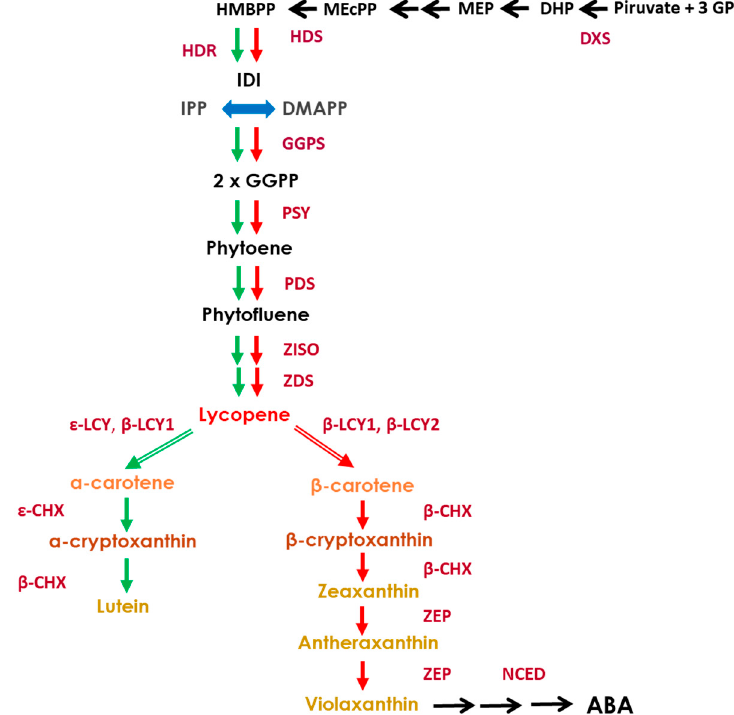
Figure 1. Schematic representation of carotenoid biosynthesis in citrus fruits, indicating main enzymes and genes of the pathway. 1-deoxy-D-xylulose-5-phosphate synthase ( DXS ), hydroxymethylbutenyl diphosphate synthase ( HDS ) and reductase ( HDR ), geranylgeranyl diphosphate synthase ( GGPSS ), phytoene synthase ( PSY ), phytoene desaturase ( PDS ), ζ -carotene isomerase ( ZISO ), ζ -carotene desaturase ( ZDS ), ε -lycopene cyclase ( ε -LCY ), β -lycopene cyclase ( β -LCY1 / 2 ), ε -carotene hydroxylase ( ε -CHX ), β -carotene hydroxylase ( β -CHX ), zeaxanthin epoxidase ( ZEP ) and 9-cis-epoxy-carotenoid dioxygenase ( NCED ). Green and red arrows represent carotenoid biosynthesis flux in green and mature tissues, respectively.